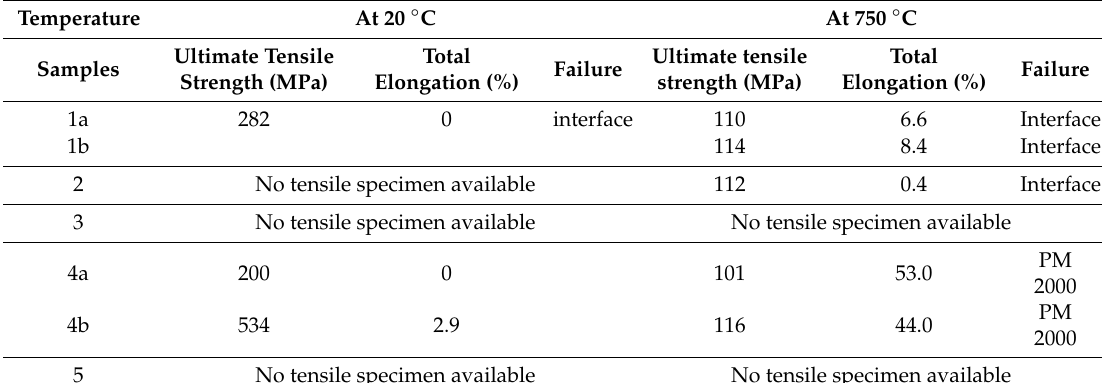
Table 3. Results of the tensile tests performed at 20 ◦ C and 750 ◦ C for the PM2000 SPS-joined disks